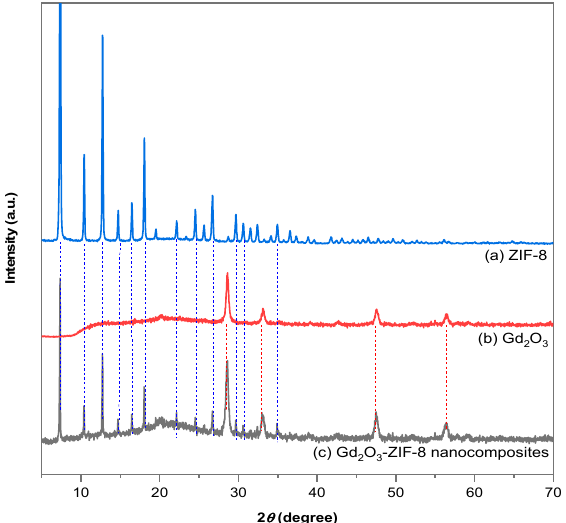
Figure 1. XRD patterns of synthesized ( a ) ZIF-8, ( b ) Gd 2 O 3 , and ( c ) Gd 2 O 3 -ZIF-8 nanocomposites. The Raman spectroscopy results of hybrid Gd 2 O 3 -ZIF-8 nanocomposites show the prominent mode of Gd 2 O 3 and major peaks of ZIF-8 in Figure 2 and the Raman shift ranges from 200 cm − 1 to 3500 cm − 1 . A peak corresponding to the F g + A g mode of the Gd 2 O 3 nanowires was observed at 358.41 cm − 1 [22,26].